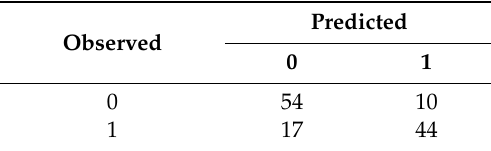
Table 5. Confusion matrix from random forest (RF) model (0 = non-landslide or negative, 1 = landslide or